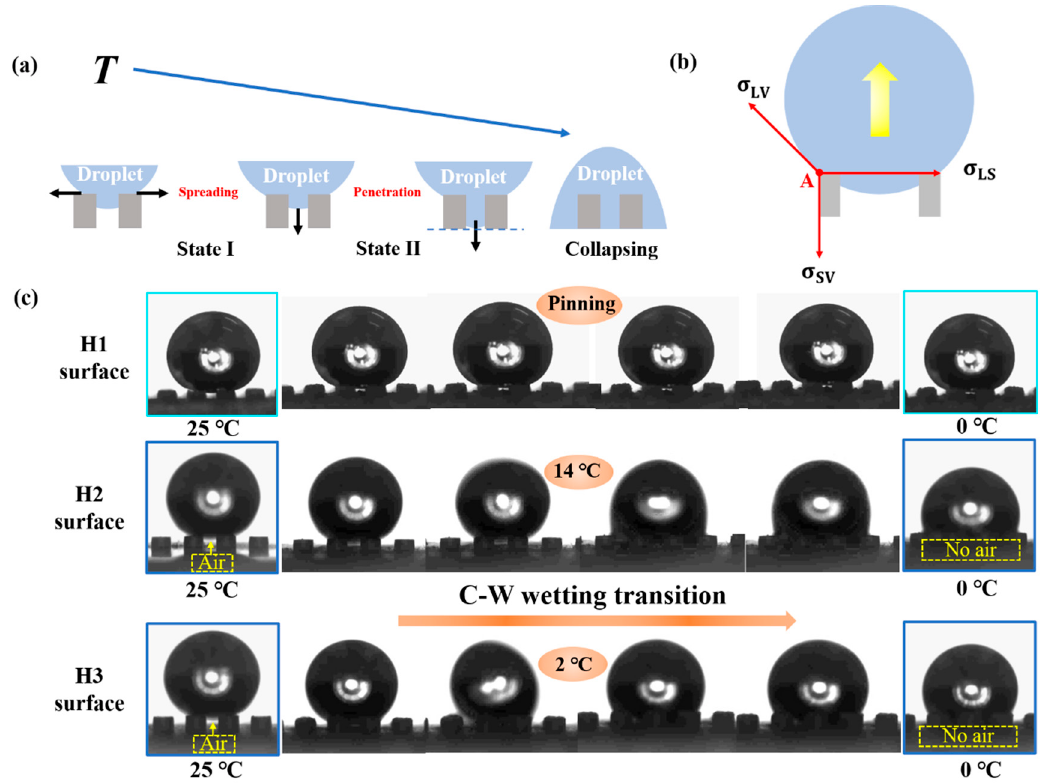
Figure 4. ( a ) Schematic diagram of contact line movement. ( b ) Schematic diagram of the direction of interface tensions when the contact line extends to the edge. ( c ) Dynamic C-W wetting transition.